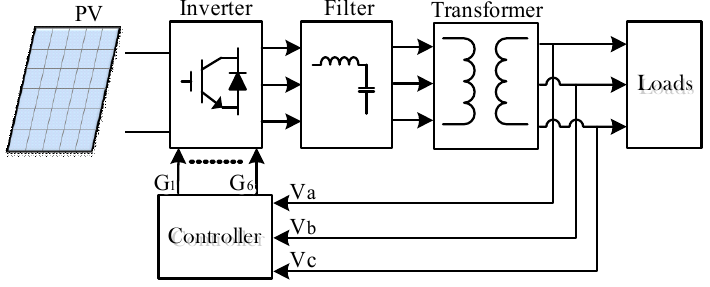
Figure 1. Structure circuit of the three ‐ phase inverter system.